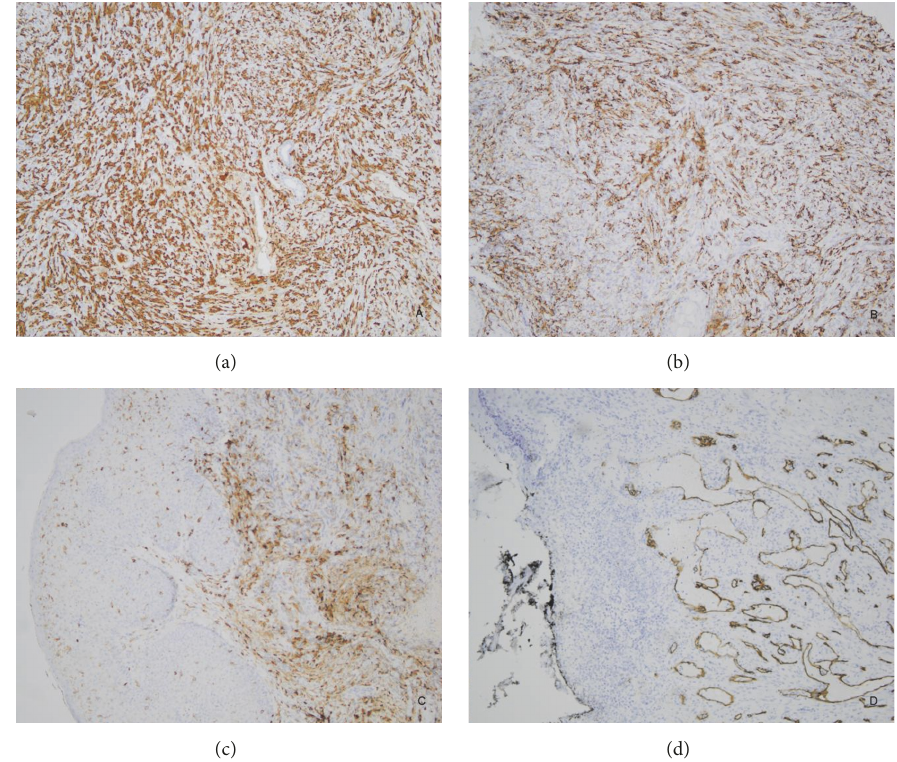
Figure 2: Immunohistochemistry was positive for (a) CD 163+, (b) CD14+, and (c) CD4+. CD163 and CD14 are expressed on macrophages, while CD4 is expressed on other cells, such as helper T-cells; CD4 is also expressed on monocytes/macrophages. Immunohistochemistry was negative for (d) CD34. CD34 negativity indicates that this neoplasm is not a myeloid